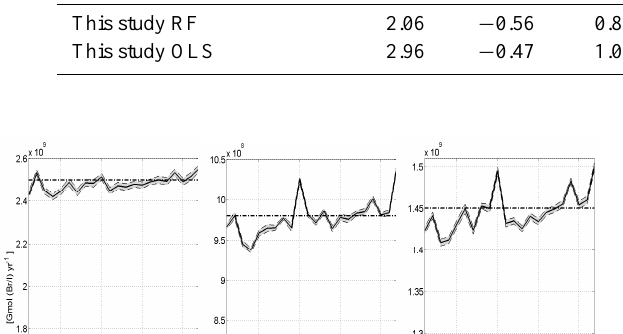
Kerkweg et al. (2008)